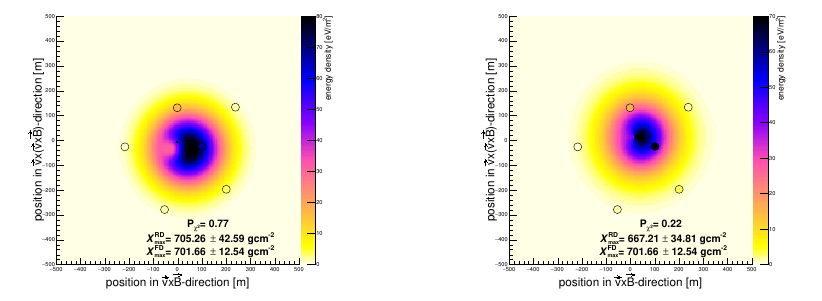
Figure 1 . Distribution of the radio signal for an AERA event. The background color map shows the values of the function that is fitted to the d ata: subtraction of two Gaussian distributions (left) and emission mechanisms parameterization (right). In the two plots it is visible the radial asymmetry created by the superposition of the two emission mechanisms. The circles represent the antennas, the color inside the station is the detected energy density. When the color inside the circles matches the background the fit is successful. In both cases the resulting X RD max is compatible with the corresponding fluorescence telescopes measurement ( X FD max